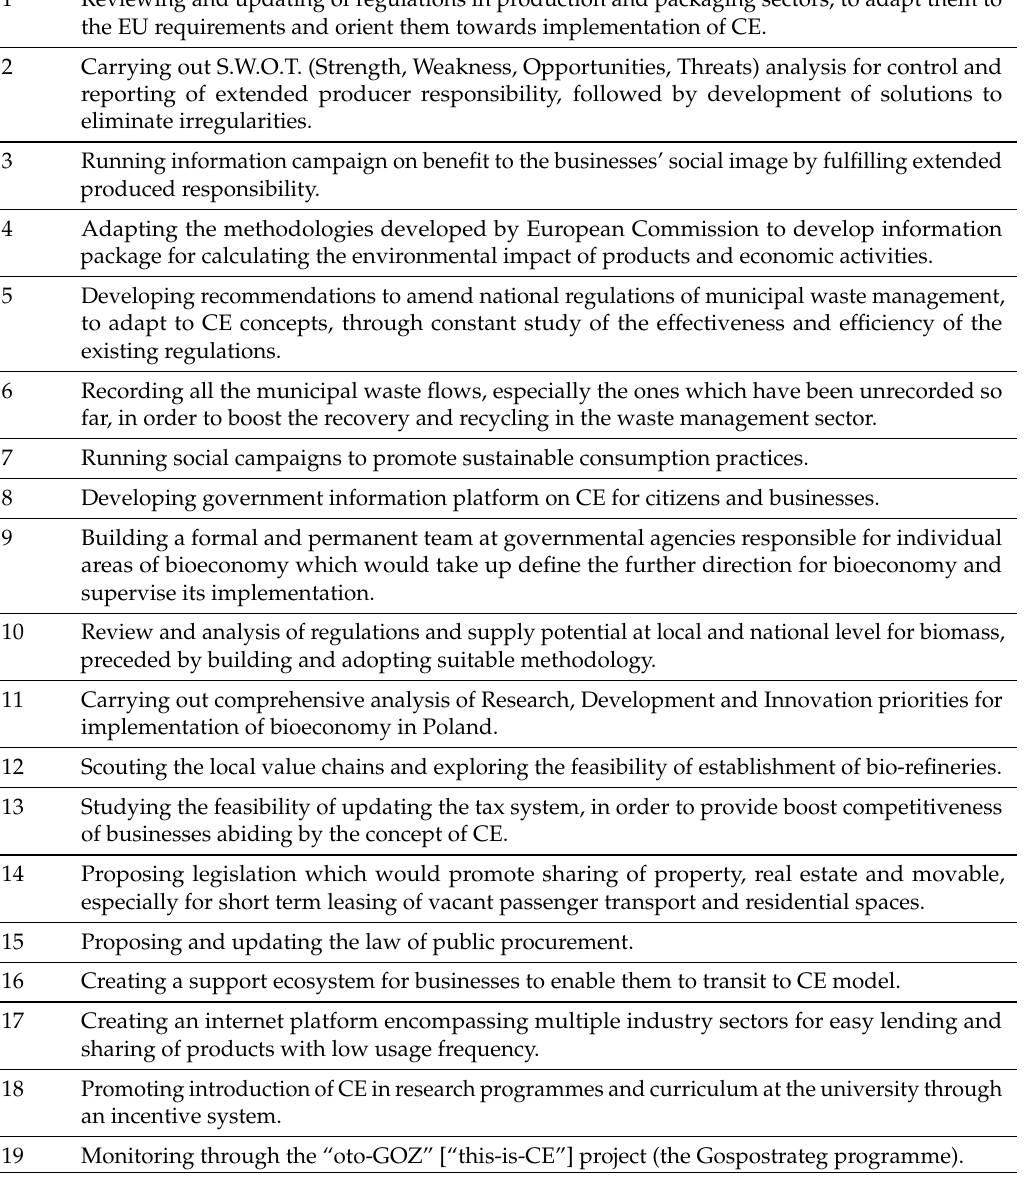
Table 1. Summary of important actions taken in Poland towards implementation of CE